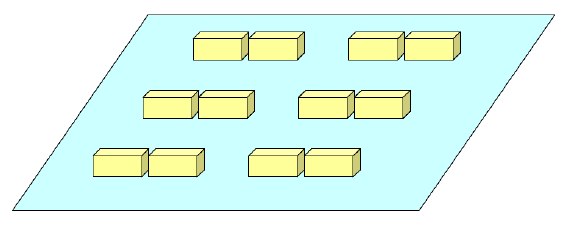
Figure 2: Nanonantenna based biosensor: two-dimensional array of dimer antenna.